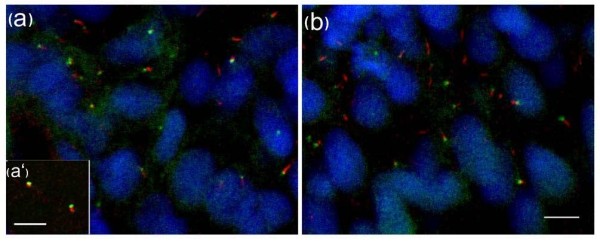
GFP-tagged Iguana (Igu) localizes to basal bodies of primary cilia in zebrafish embryos. GFP-igu mRNA was injected into 1-cell stage embryos and injected embryos fixed and labelled with anti-acetylated tubulin (red). Punctate GFP-Igu localization was excluded from the axoneme (a). Co-injection of mRNA encoding tdTomato fused GTAP3 (γ-tubulin associated protein 3) and GFP-Igu, revealed co-localization of both proteins at the basal bodies in live early somitogenesis stage embryos (a'). The basal body localization of GFP-Igu was un-altered in embryos expressing dnPKA (b). Scale bars: 5 μm